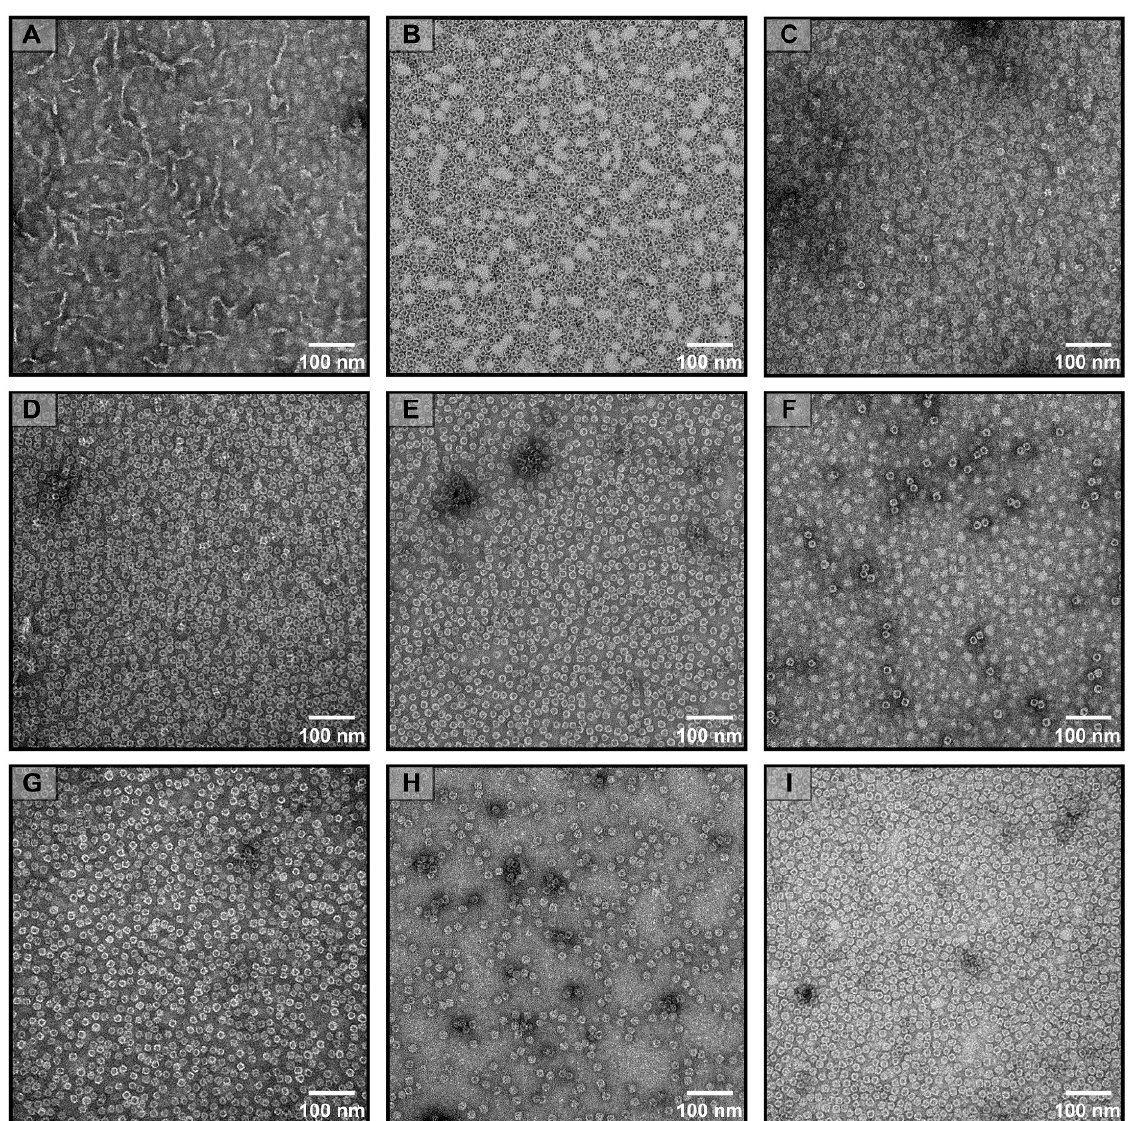
Figure 2. Transmission electron microscope scanning images corresponding to different pH conditions of DzFer and metal-bound DzFer. TEM images under pH 2 ( A ), pH 4 ( B ), pH 6 ( C ), pH 8 ( D ), pH 10 ( E ), and pH 12 ( F ) conditions. ( G – I ) TEM images of DzFer, Ag + -DzFer, and Cu 2+ -DzFer proteins.